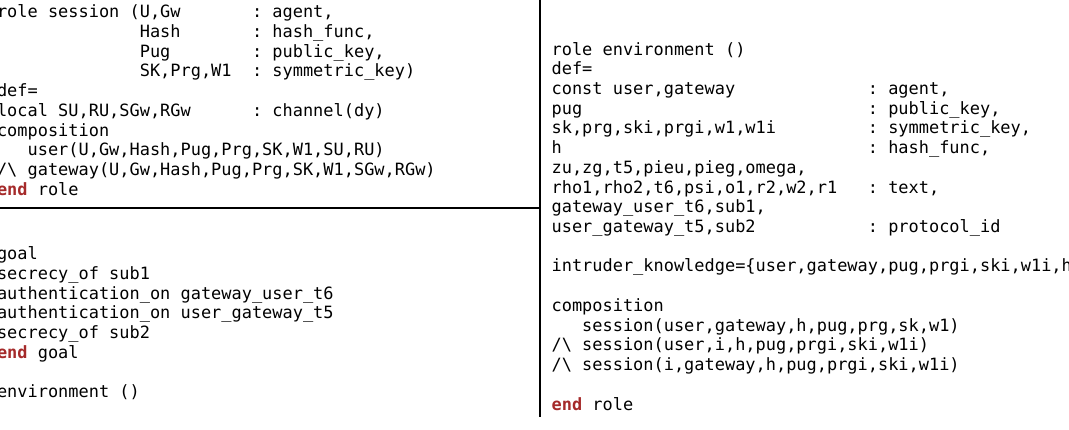
Figure 7. AVISPA Role Specification of the Session, Environment and Goal for MAKE-IT Protocol. File: /home/span/Desktop/IoT HAN Modified/IIOT NEW/OFMC